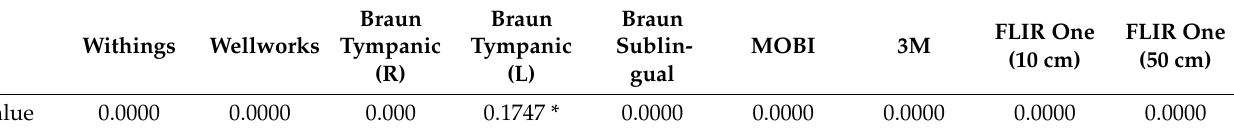
Figure 4. Body temperature changes over time. Table 3. Results of the sign test between each device and the gold